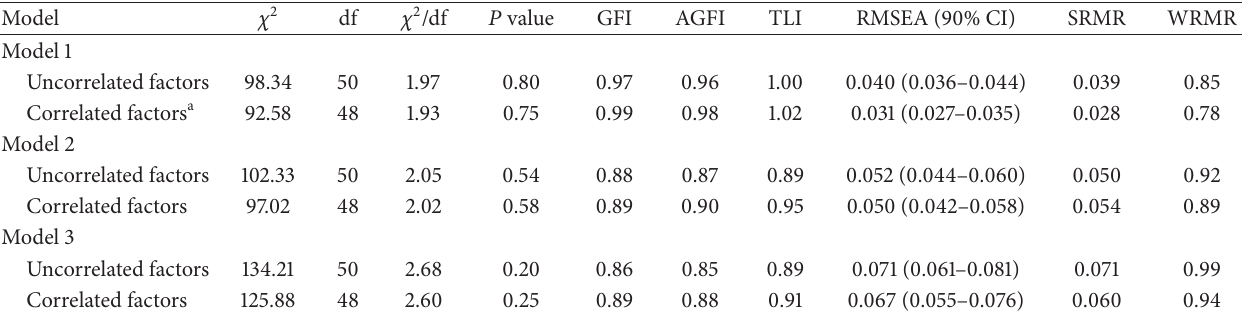
Table 4: Summary of fit indices of three-hypothesized models of LEE scale ( 𝑁 = 262 ).